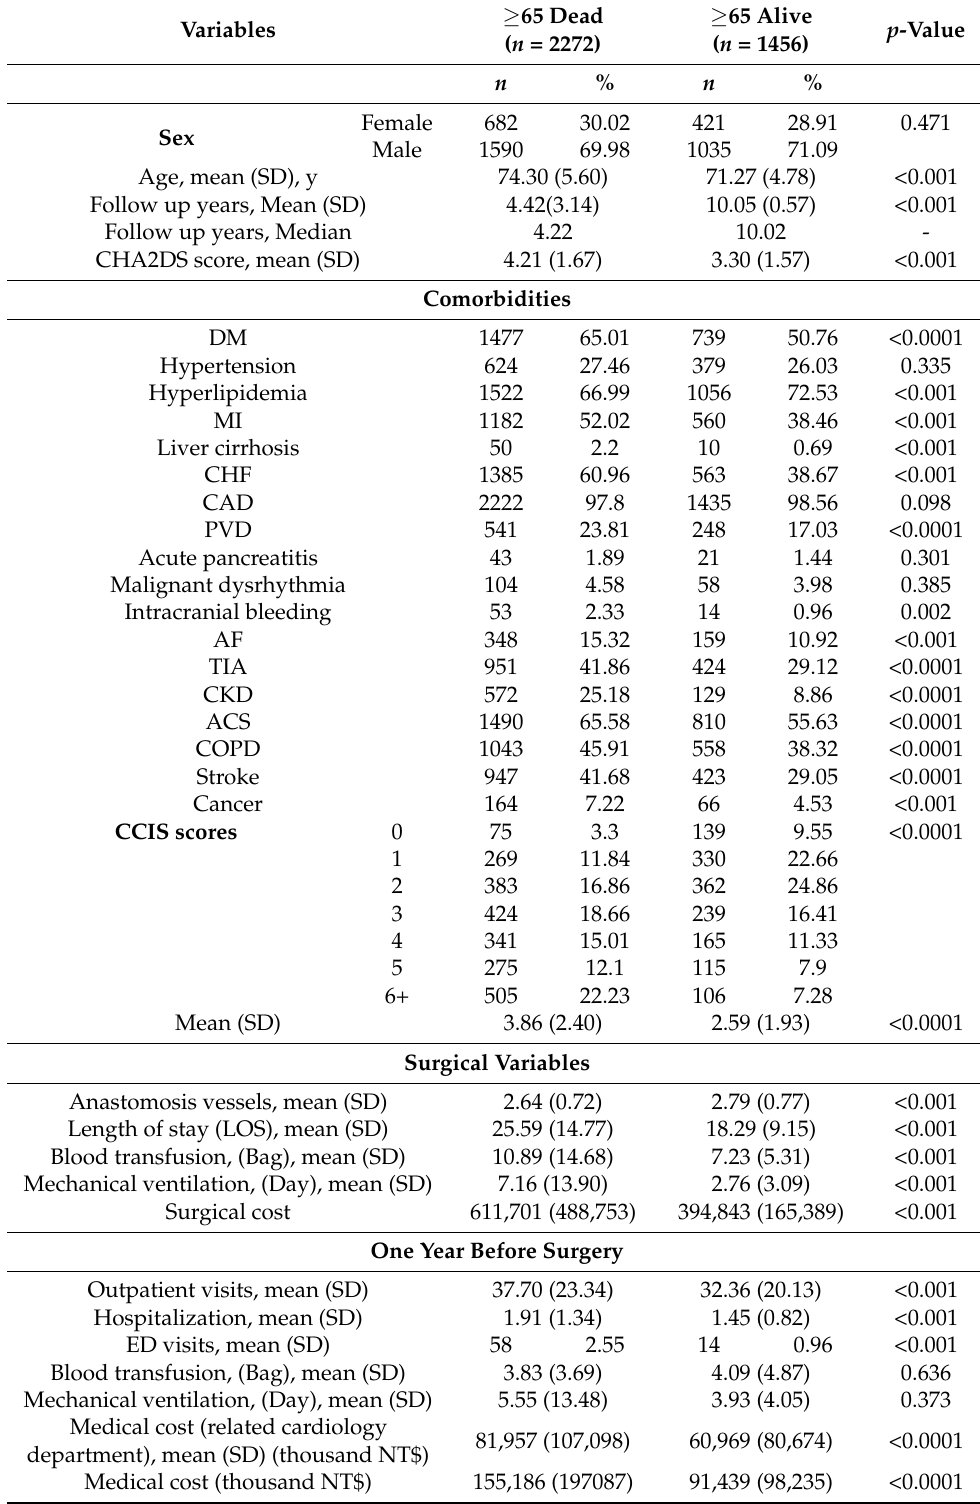
Table 1. Demographic features of older CABG adults in Taiwan from 2008 to